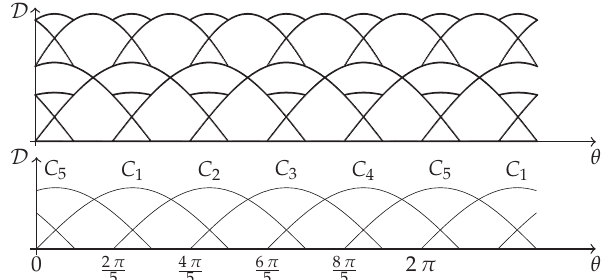
Figure 10: Illustration of the displacement combina- tions as function of the shaft angle with 5